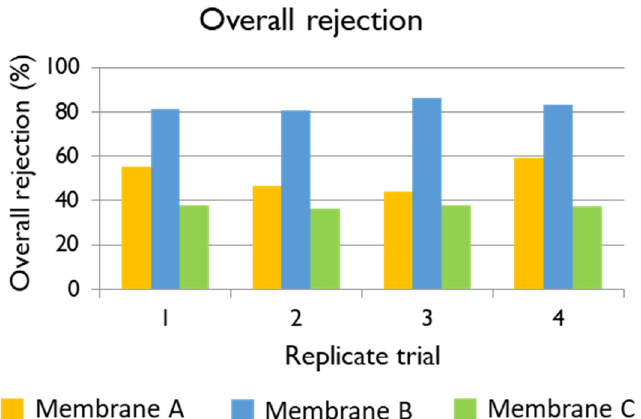
Figure 9. Overall rejection based on conductivity in experiments with black liquor with membranes A, B and C.